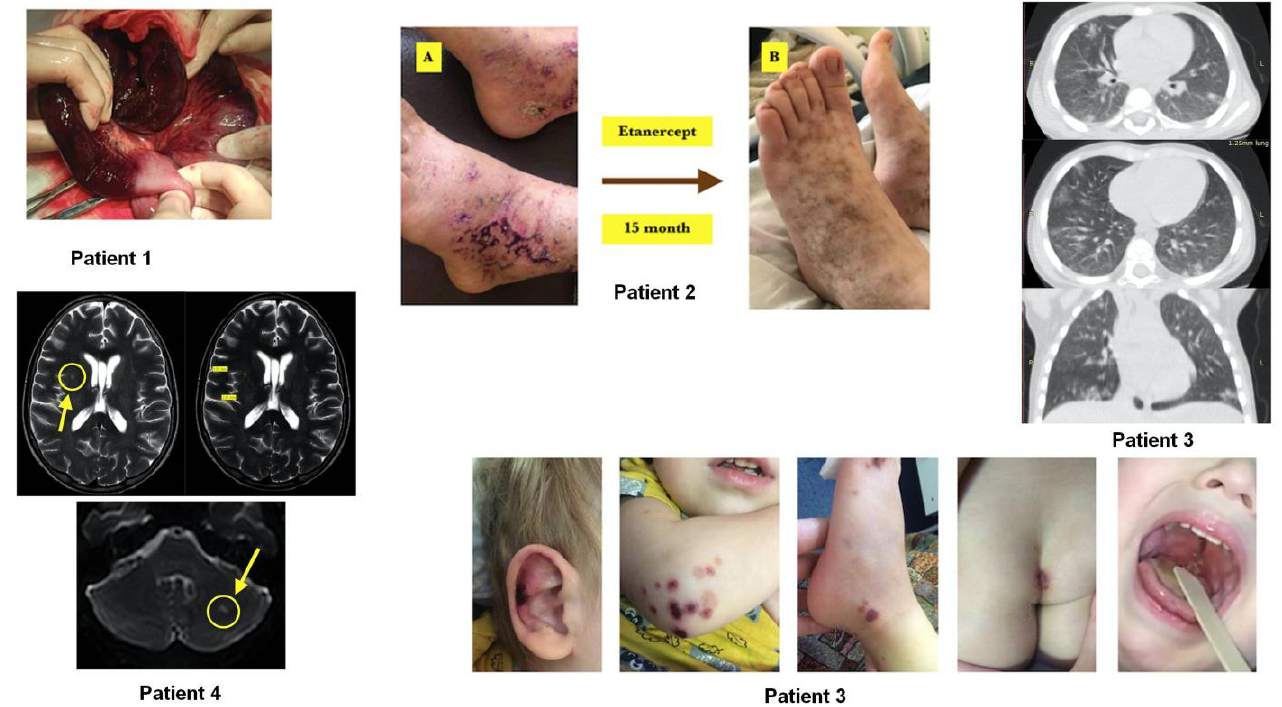
Figure 1. (1) Intraoperative pictures of patient 1: mesenteric vein thrombosis, intestine necrosis, and hemorrhagic peritonitis. (2) Skin manifestations in patient 2 before treatment ( A ) and after treatment ( B ). (3) Ischemic changes in patient 3 and scan of patient 3’s chest organs had shown areas of reduced pneumatization and enhanced density with ground-glass opacities. (4) Brain MRI of patient 4. Arrows show hyperintense foci in the cerebellum with cytotoxic edema (in the bottom) and areas of ischemic infarction in the white matter (upper part).